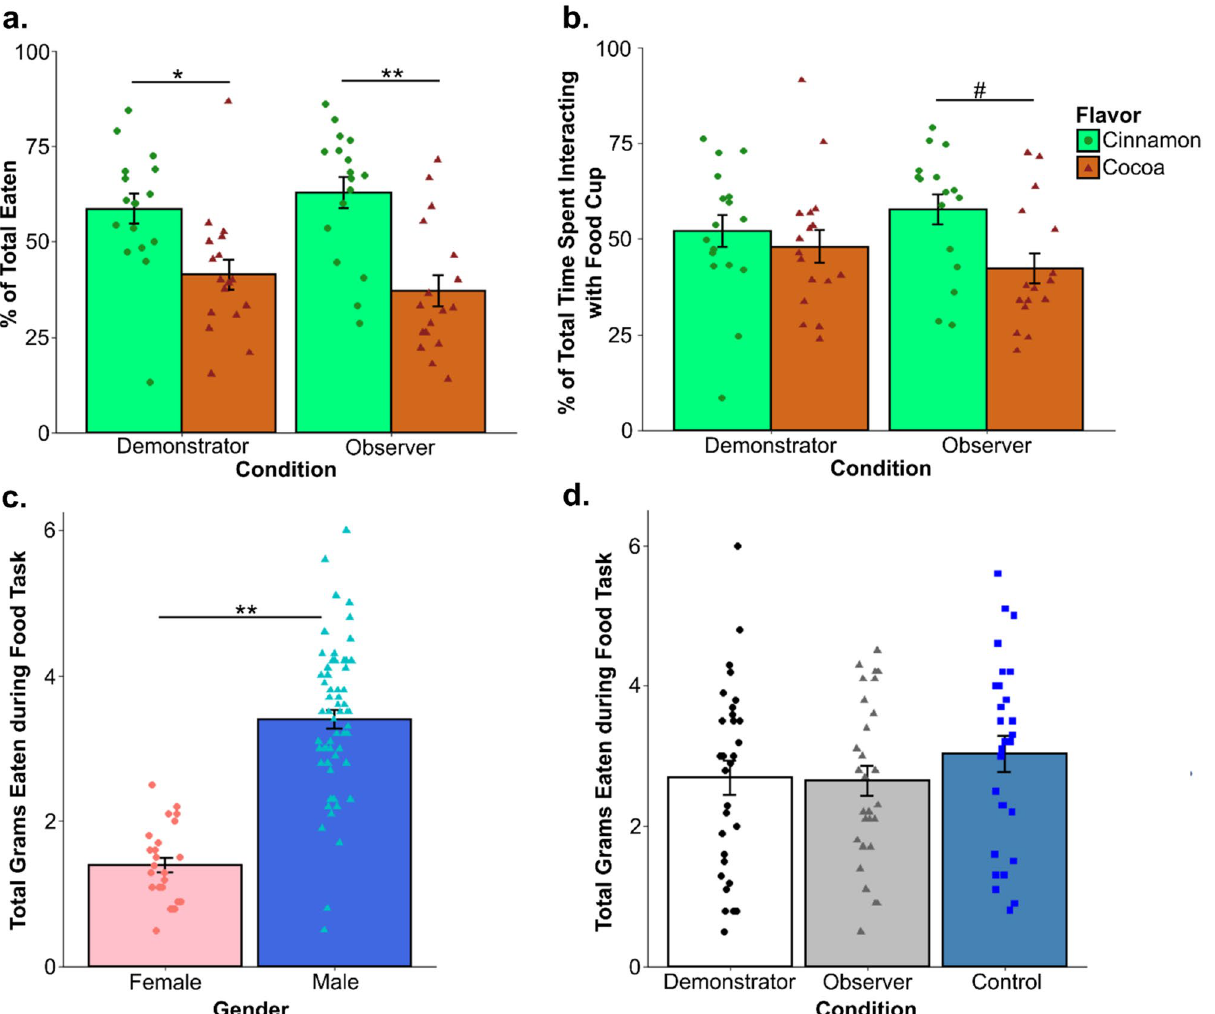
Figure 4. Day 4 food task behavioral results. For rats that went through the choice test on the final day of experimentation, we found that ( a ) while observers and demonstrators did not differ significantly from each other in the percent of diet Cin (the demonstrated flavor) eaten, they did both show a significant preference for the diet. However, ( b ) neither group spent significantly more time interacting with the food cup containing diet Cin. Examining the total amount eaten during the final food task for all rats we predictably found that ( c ) females overall ate significantly less than males. ( d ) Experimental condition has no overall effect on the total amount eaten . All graphed values are the mean ± SEM. #p < 0.1, *p < 0.05, **p <